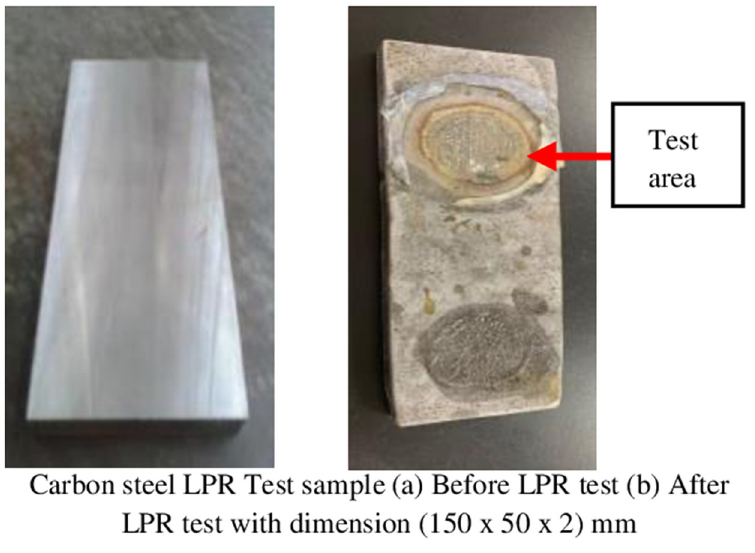
Fig 11. Specimen sample before and after LPR